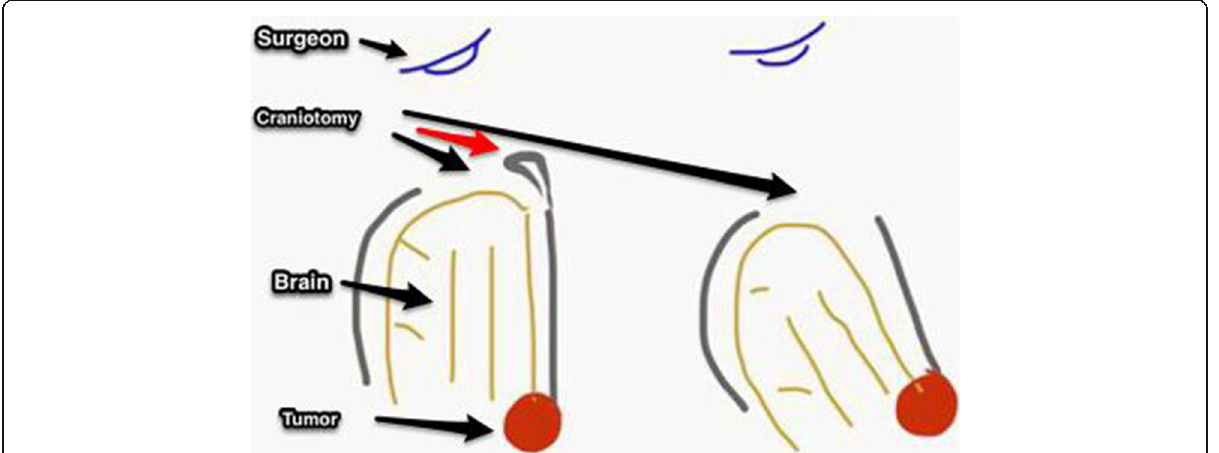
Fig. 2 Diagram of lesion in the sellar suprasellar region (left part), demonstrating the importance of patient positioning and design of craniotomy (right part) to avoid fixed retraction